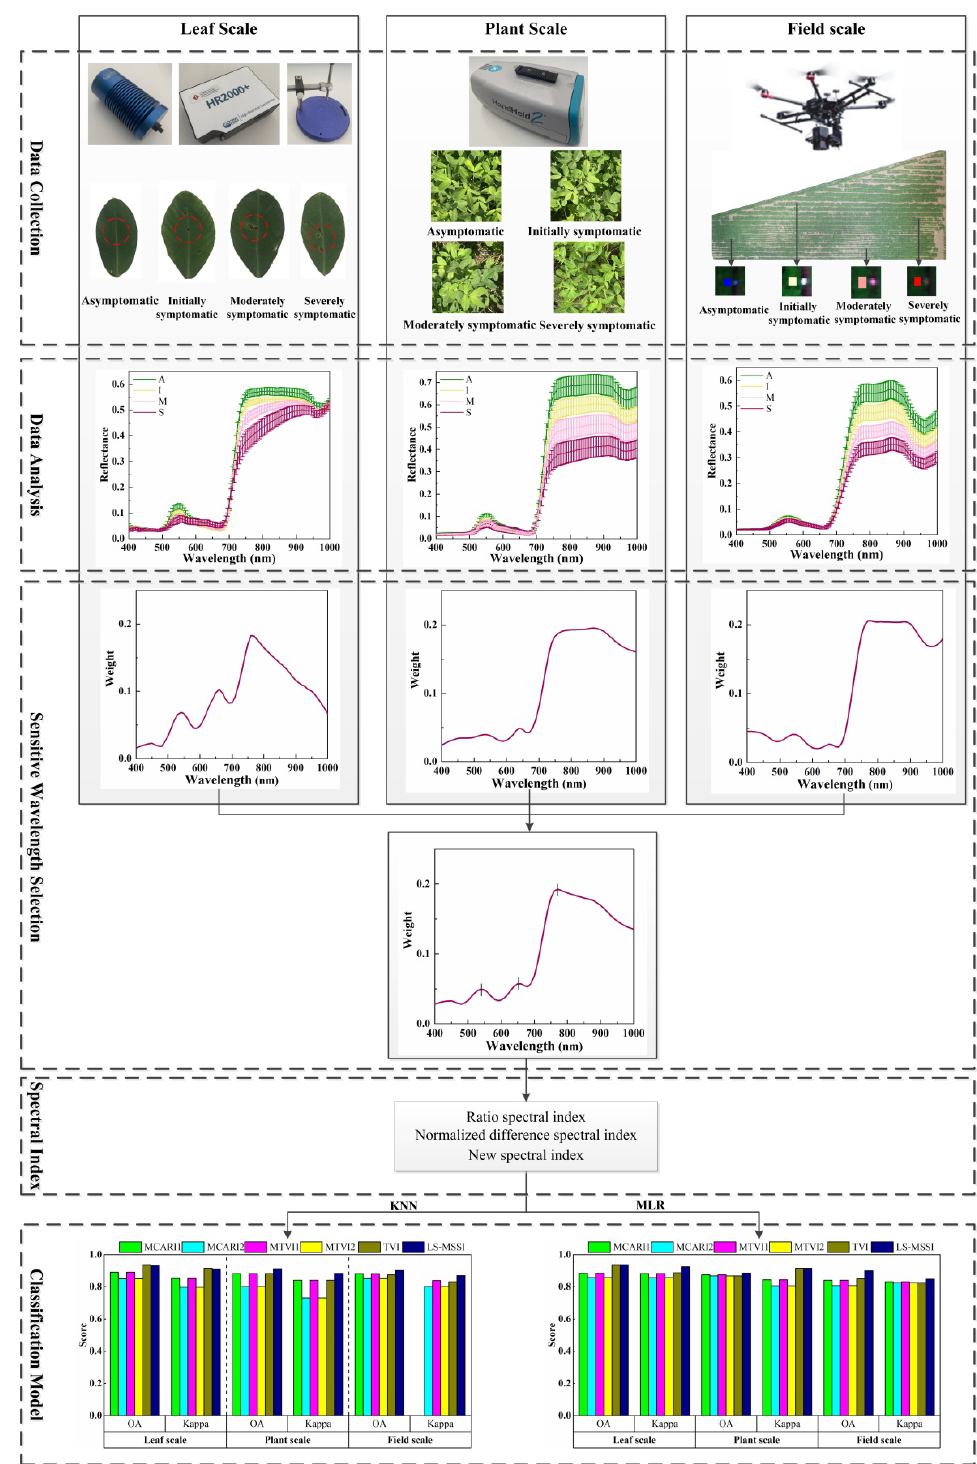
Figure 5. Flowchart of peanut LS detection using multi-scale hyperspectral reflectance.